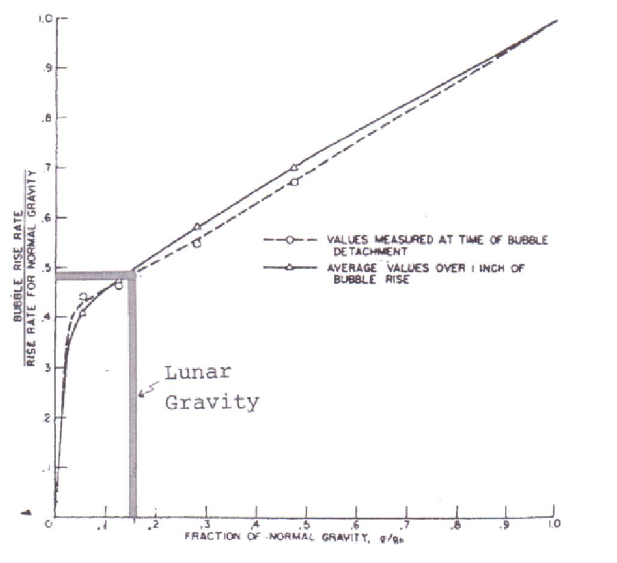
Figure 3. Bubble Rise Rates. Slower rise rate of bubbles under low gravity modified after Usiskin and Siegel [9]. Under lunar gravity, the rise rate of bubbles, all other factors held constant, will be about one half the rise rate of bubbles under Earth gravity. Bubble diameters would also be about 1.7 times larger holding pressure